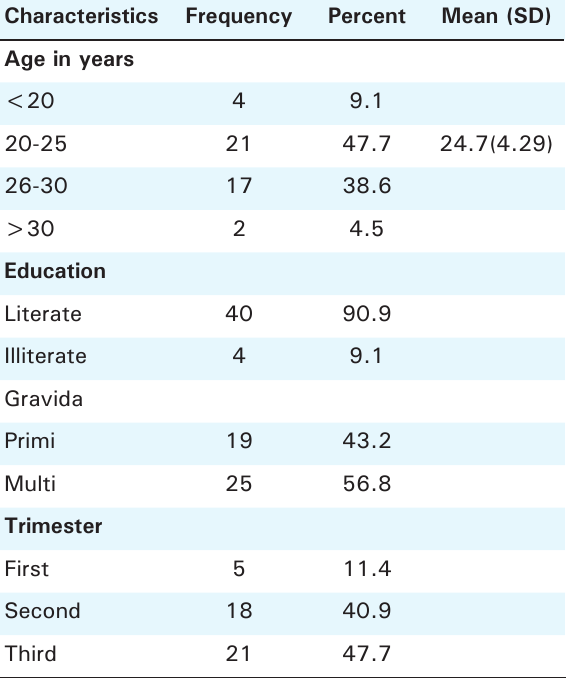
Table 1. Socio-obstetrical characteristics of the respondents